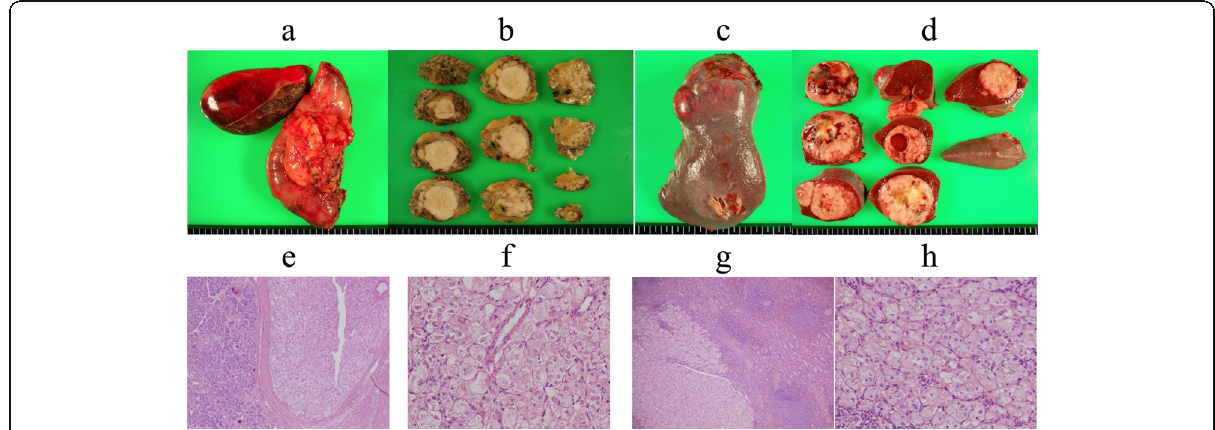
Fig. 3 Findings of the resected specimen. The macroscopic and microscopic findings of the cut specimen revealed gray and clear borders between the tumor and pancreas ( a , b ) and spleen ( c , d ), and yellow and unclear border between the tumor and liver. Pathological examination showed that atypical cells with eosinophilic granular cytoplasm had proliferated to form alveolar solid nests in the pancreas ( e , f ) and spleen ( g , h ). The pathological examination further showed focal nodular hyperplasia at the